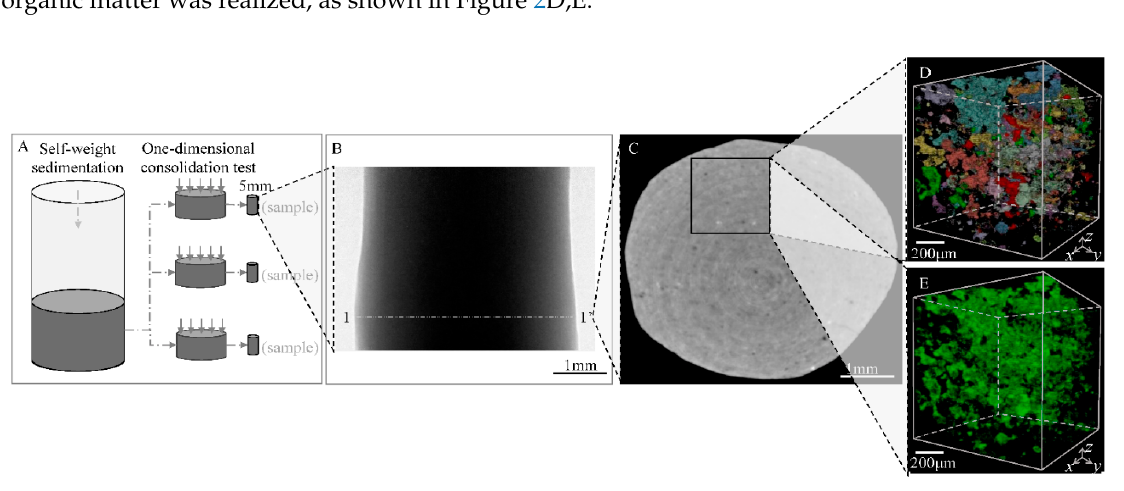
Figure 2. Experiments and modeling process. ( A ) Sample preparation after physical simulation experiment; ( B ) A projection image after background correction of one sample; ( C ) CT slice after reconstruction of the sample; ( D ) Distribution of organic clusters; ( E ) Distribution of organic matter.